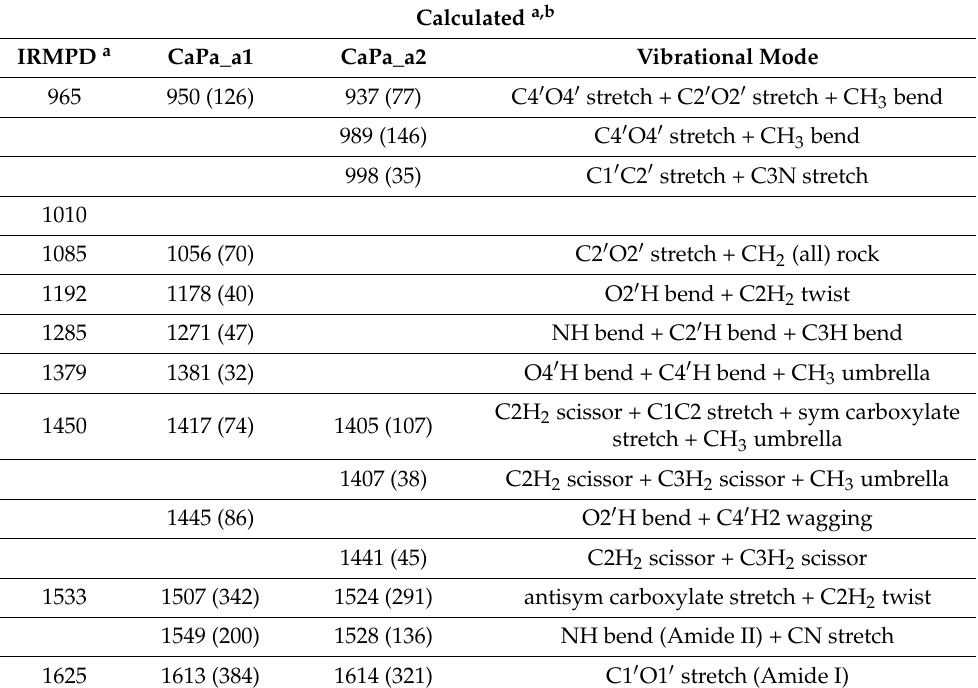
a in cm − 1 . b intensities in parentheses in km mol − 1 . Vibrations with intensities lower than 30 km mol − 1 are